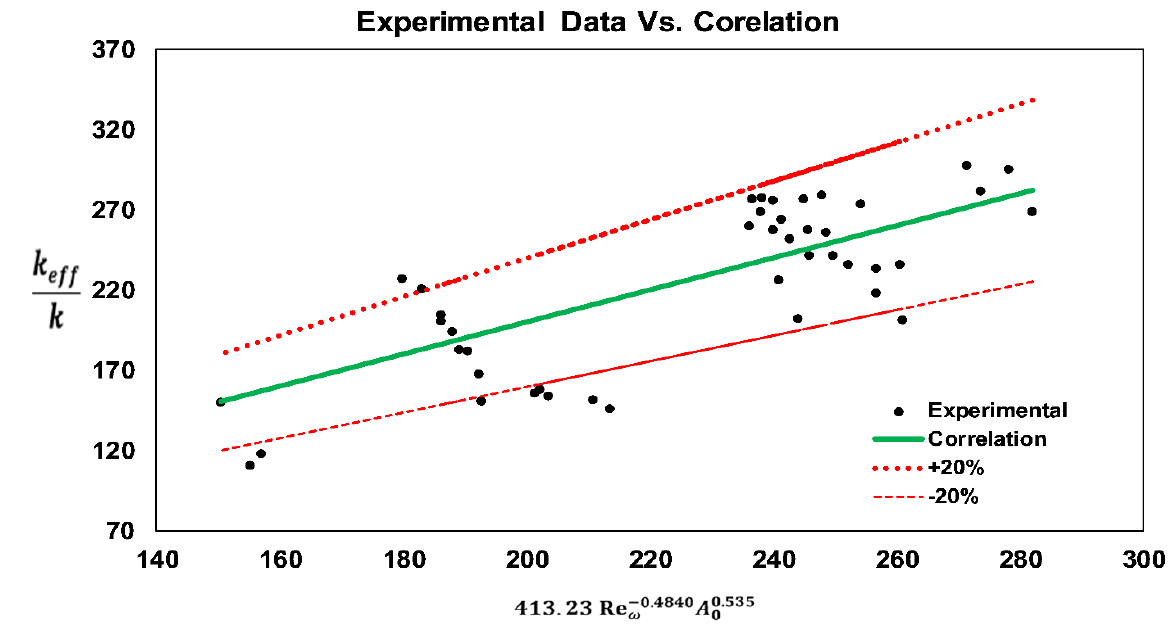
Figure 7. Comparison between the correlation and experiment data.